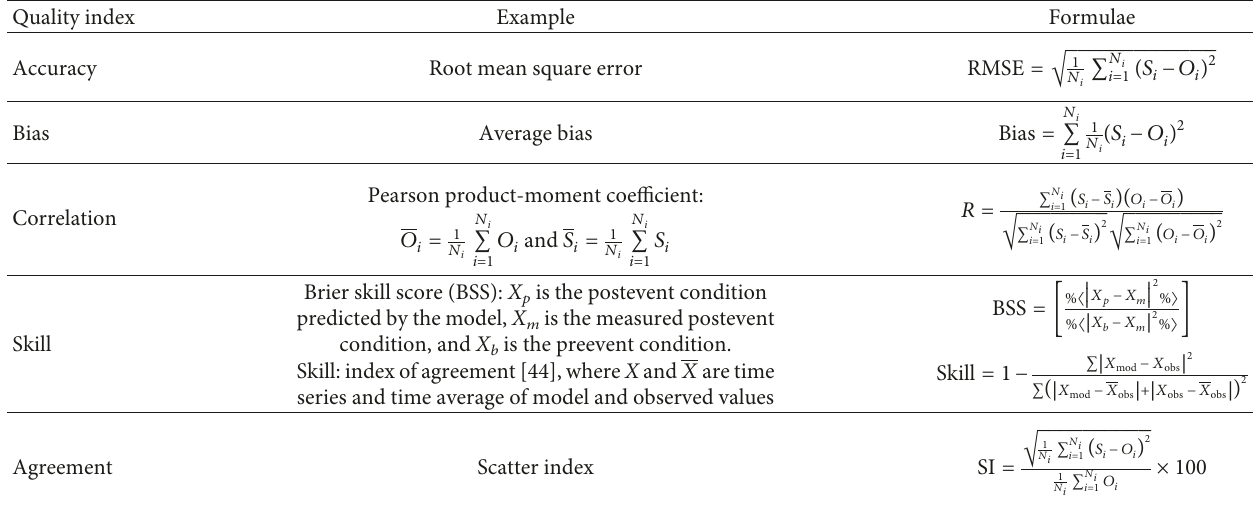
Table 4: Example statistics to demonstrate the level of agreement between measured/observed data and model prediction. Quality